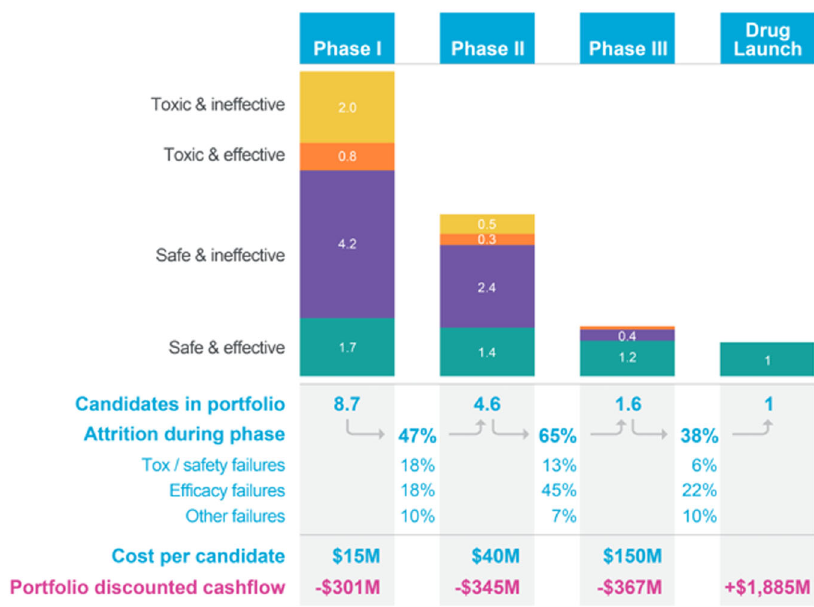
Fig. 2 Economic value model for assessing the fi nancial impact of improved preclinical testing. Illustrated is the model ’ s “ base case ” , which tracks a representative portfolio of candidate drugs as it progresses and erodes through clinical trials, culminating in a single drug approval. The model bases phase- by-phase attrition rates ( “ attrition during phase ” ), discovery and preclinical costs, development costs ( “ cost per candidate ” ) and cost of capital on Paul et al. 5 to compute a portfolio-wide discounted cash fl ow. In contrast with prior approaches, the model tracks the underlying causes of clinical trial failure (safety-related, ef fi cacy-related, and other failures) using parameters derived from literature 7,9,24,25 , a feature that permits us to determine the composition of the drug portfolio in each stage of development in terms of candidates that are safe and effective, safe and ineffective, unsafe and effective, and unsafe and ineffective, as illustrated. Improvements in the predictive validity of preclinical safety testing can be captured through their impact on the makeup of the portfolio entering Phase I clinical trials: better preclinical safety testing reduces the proportion of unsafe drugs that enter the clinic relative to the “ base case ” ; the model permits analyzing the impact of such changes on the discounted cash fl ow and the portfolio ’ s pro fi tability. The model is provided in full in Supplementary Data 2 as a formula-driven Microsoft Excel fi